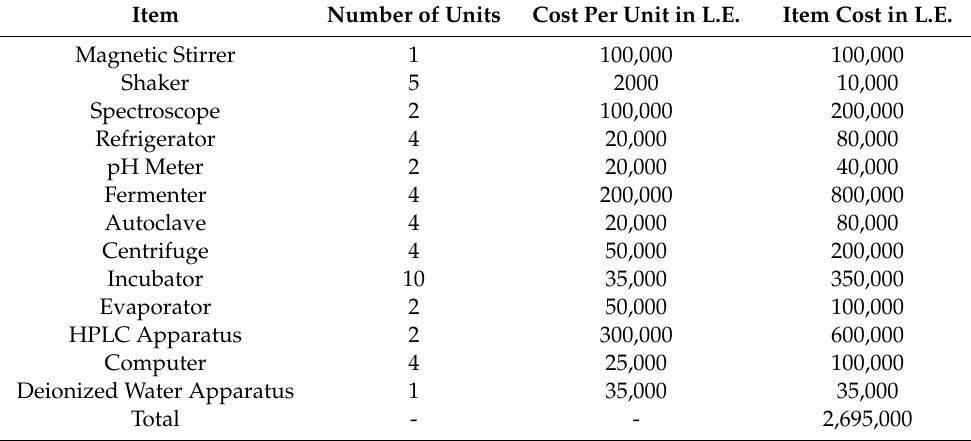
Table 5. Investment costs [68].